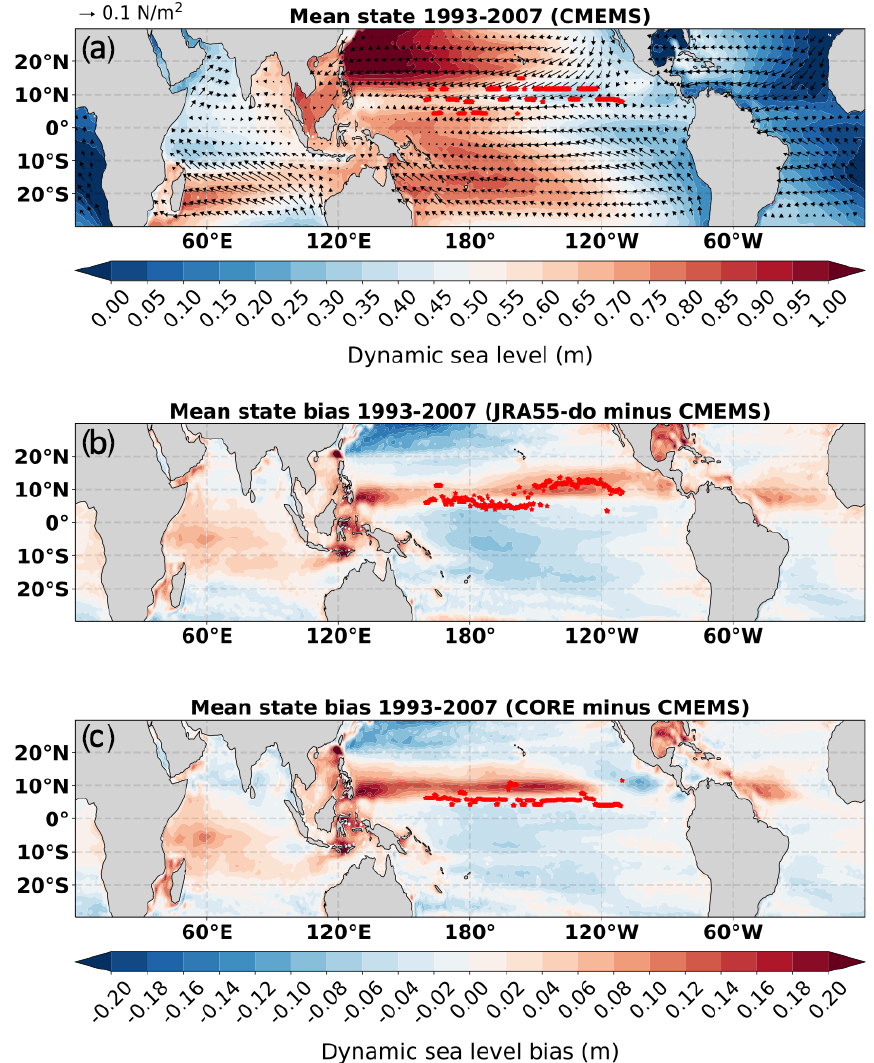
Figure 3. (a) The shaded color shows the DSL time mean (1993–2007) from satellite altimeter measurements (CMEMS) and the vector field shows the wind stress time mean from WASwind (see the 0 . 1Nm − 2 vector in the upper left for scale). The shaded color shows DSL bias in (b) the JRA55-do-forced simulation and (c) the CORE-forced simulation during the 1993–2007 period. The red stars indicate the Intertropical Convergence Zone (ITCZ) location as determined by the maximum wind convergence at each longitude over the tropical